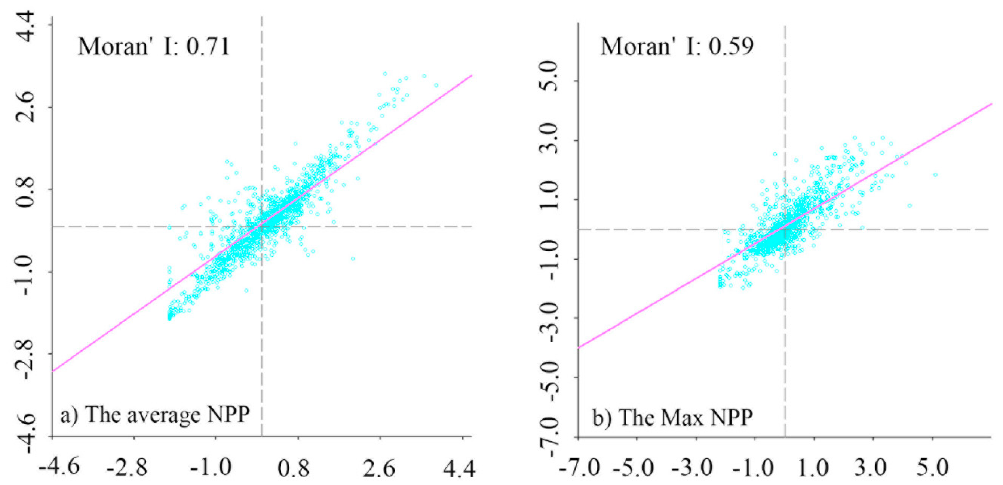
Figure 2. Scatterplot of mean value (a) and maximum value (b) of NPP in county administrative